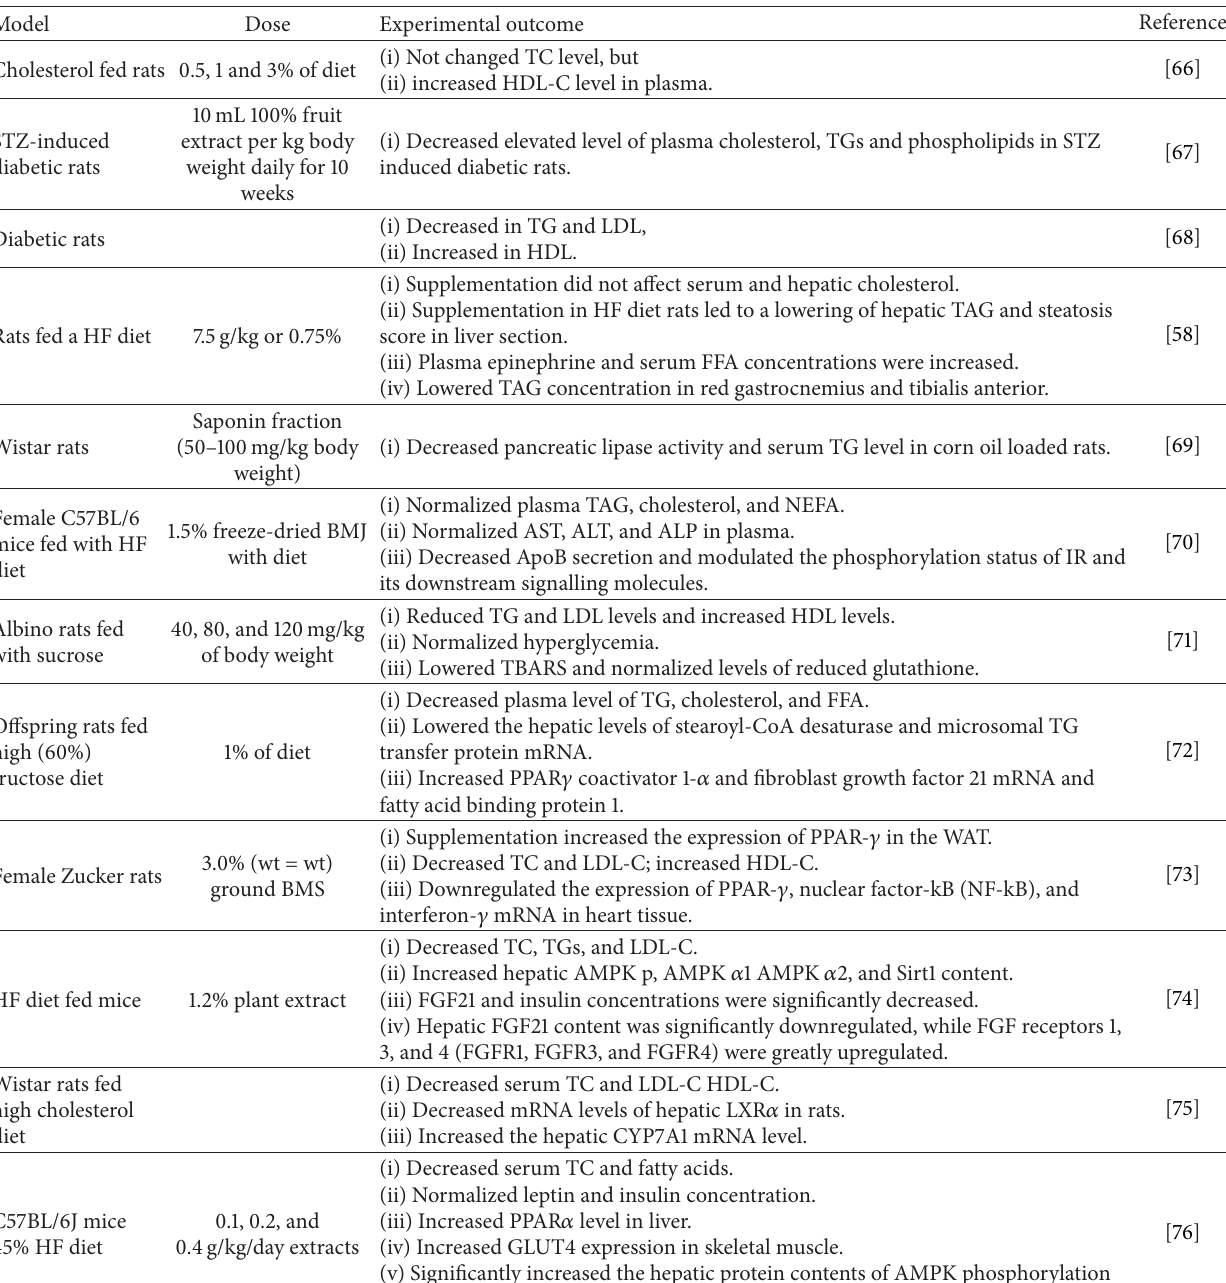
Table 2: Effect of bitter melon extracts on lipid parameters of diabetic and obese animal models. Model